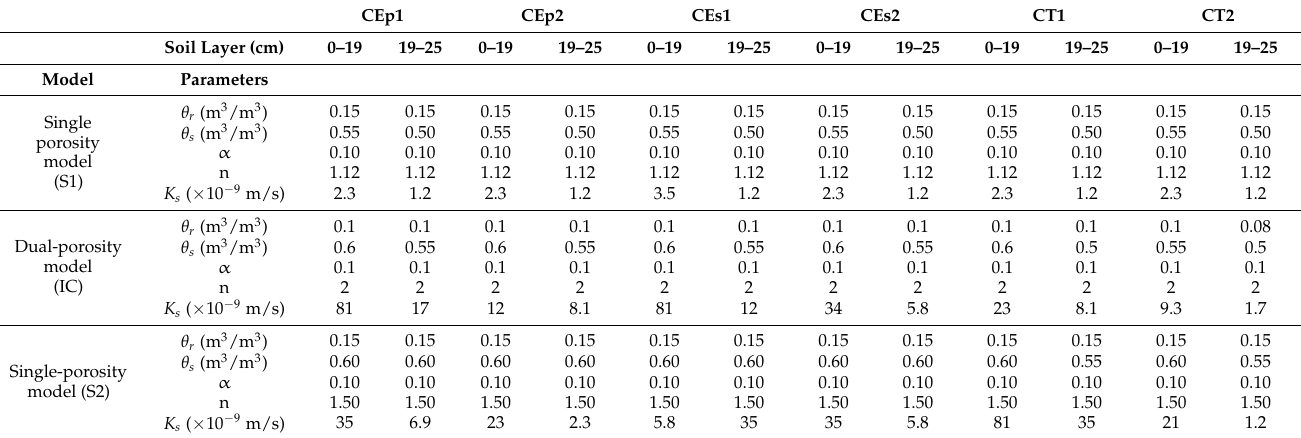
Table 2. Soil hydraulic parameters used to simulate two soil layers during the first cropping season (S1), the intercropping season (IC) and the second cropping season in the six columns. The parameters are residual volumetric water content ( θ r ), saturated volumetric water content ( θ s ), a shape parameter ( α ) that is related to the air entry potential of the soil, another shape parameter (n) and the saturated hydraulic conductivity ( Ks ). CT1 and CT2 are the columns with bare soil, CEs1 and CEs2 are the columns cultivated with seasonal E. stagnina and CEp1 and CEp2 are the columns cultivated permanently with E. stagnina